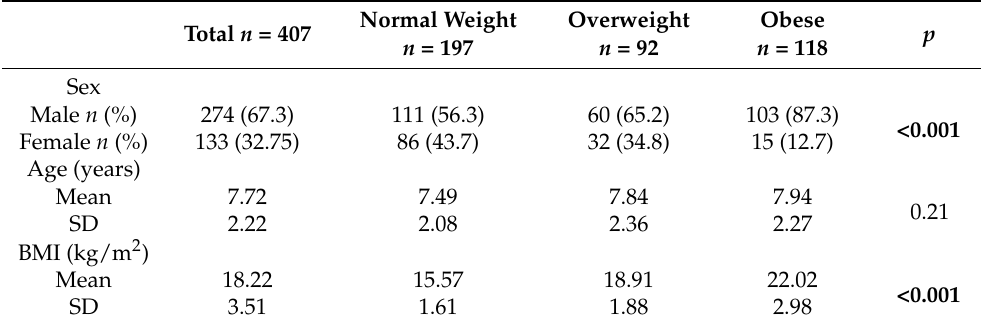
Table 1. Demographic and anthropometric characteristics of the study patients and comparison of subgroups.